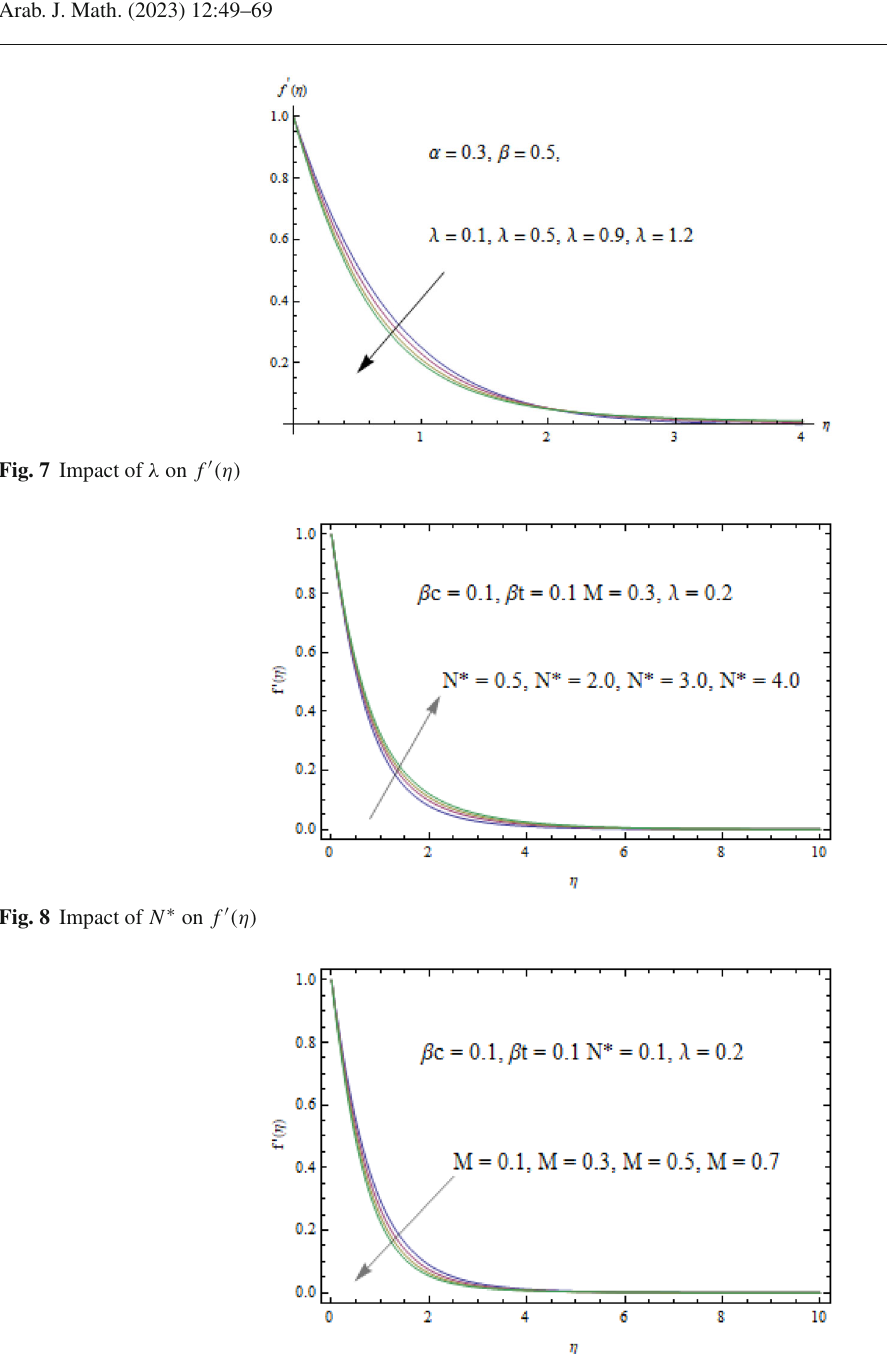
Fig. 9 Impact of M on f (cid:5)